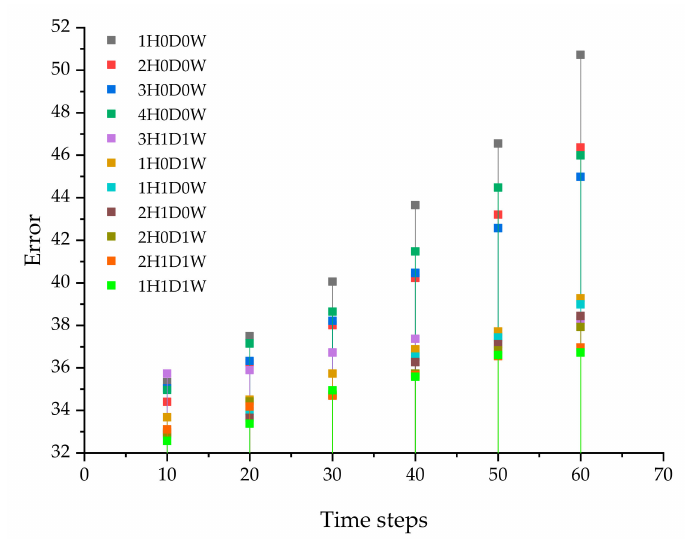
Figure 9. Prediction results of GCTN in different time patterns data